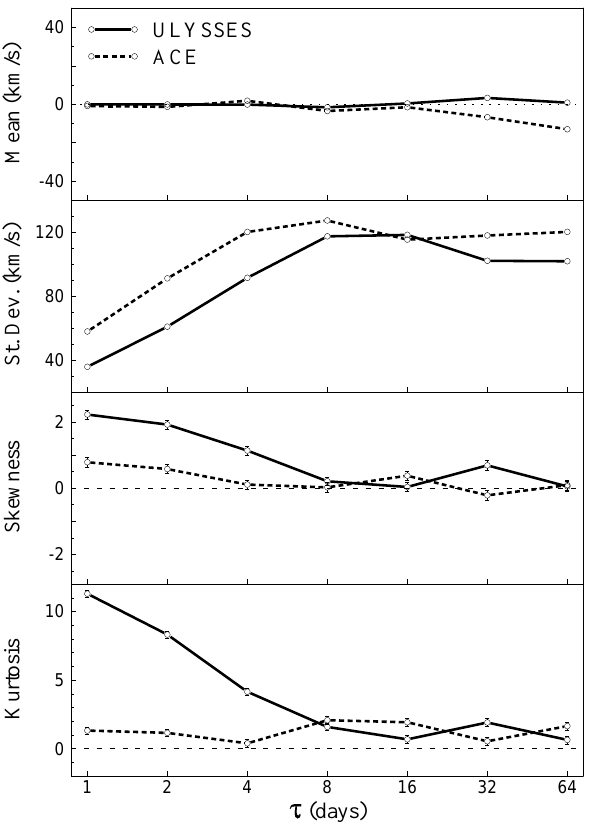
Fig. 8. Mean, standard deviation, skewness, and kurtosis vs. time lag τ for the VHL interval, in the same format of Fig.